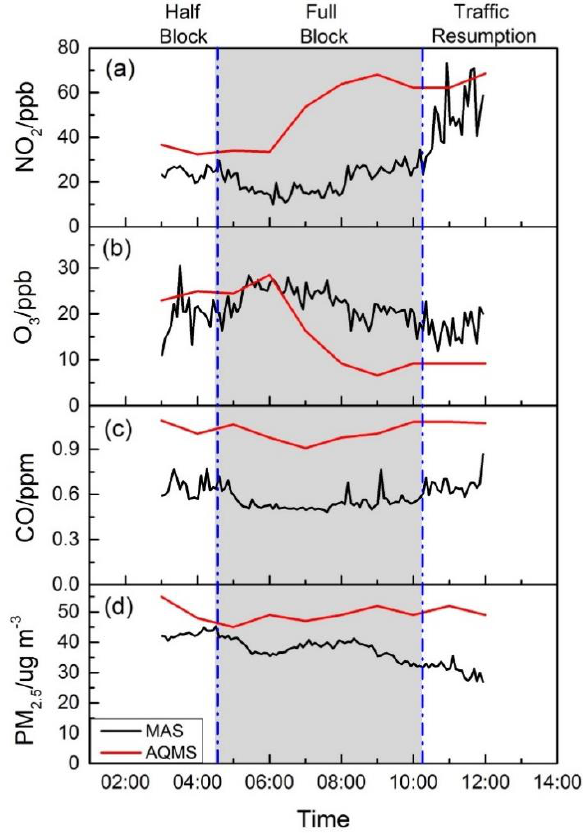
Figure 8. The pollutants’ concentrations before, during and after the Marathon at TST from MAS and at Mong Kok from AQMS. ( a ) Time series for NO 2 ; ( b ) time series for O 3 ; ( c ) time series for CO; ( d ) time series for PM 2.5 .